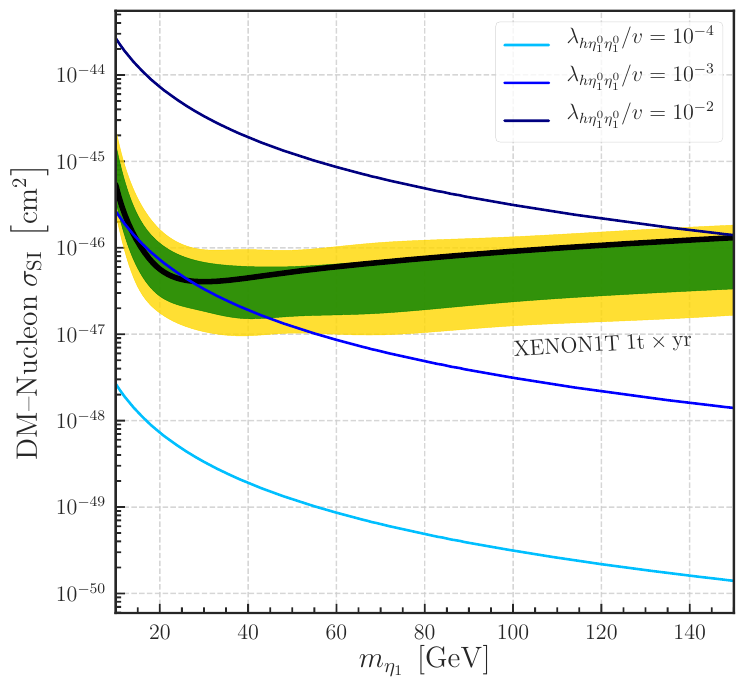
Figure 7 . Spin-independent DM-Nucleon scattering cross section as a function of the DM mass m (cid:17) for several values of the (cid:21) coupling. The black curve shows the 90% con(cid:12)dence level upper h(cid:17) 0 1 (cid:17) 0 1 1 limit obtained from the XENON1T experiment with a 1 : 0t 1yr exposure. The green and yellow (cid:2) region marks the 1 and 2 (cid:27) sensitivity bands for the XENON1T